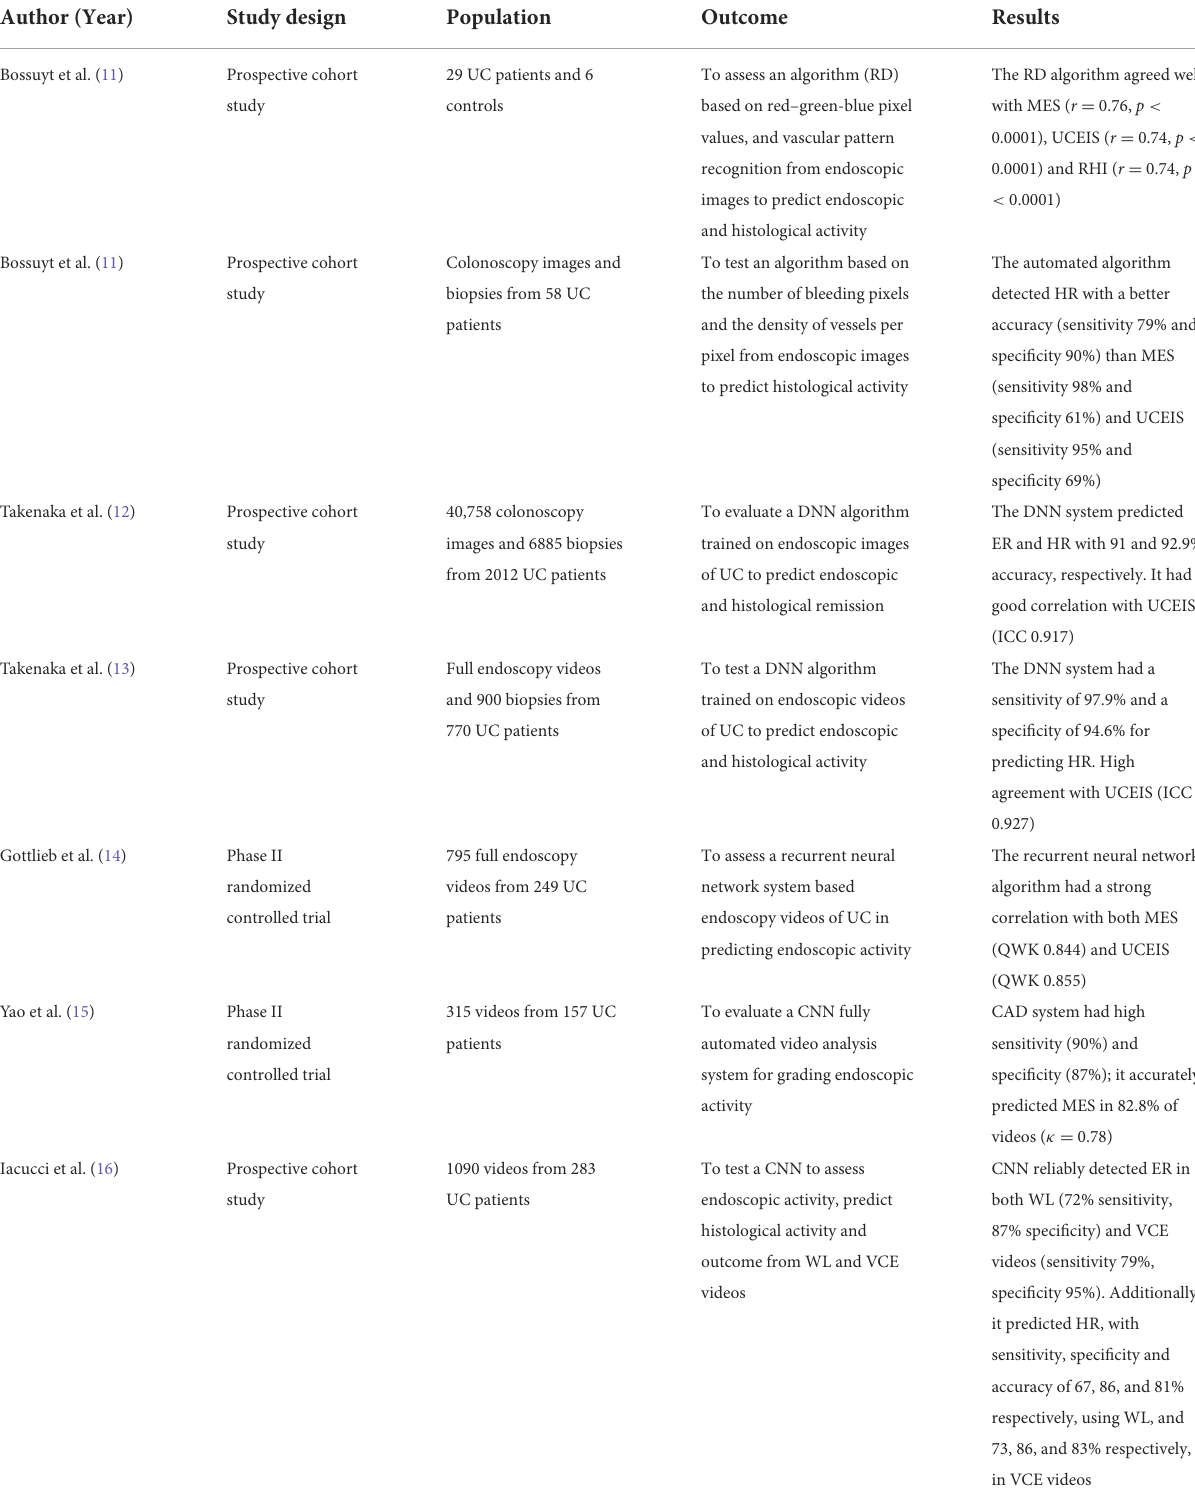
TABLE 1 Studies of AI application for IBD